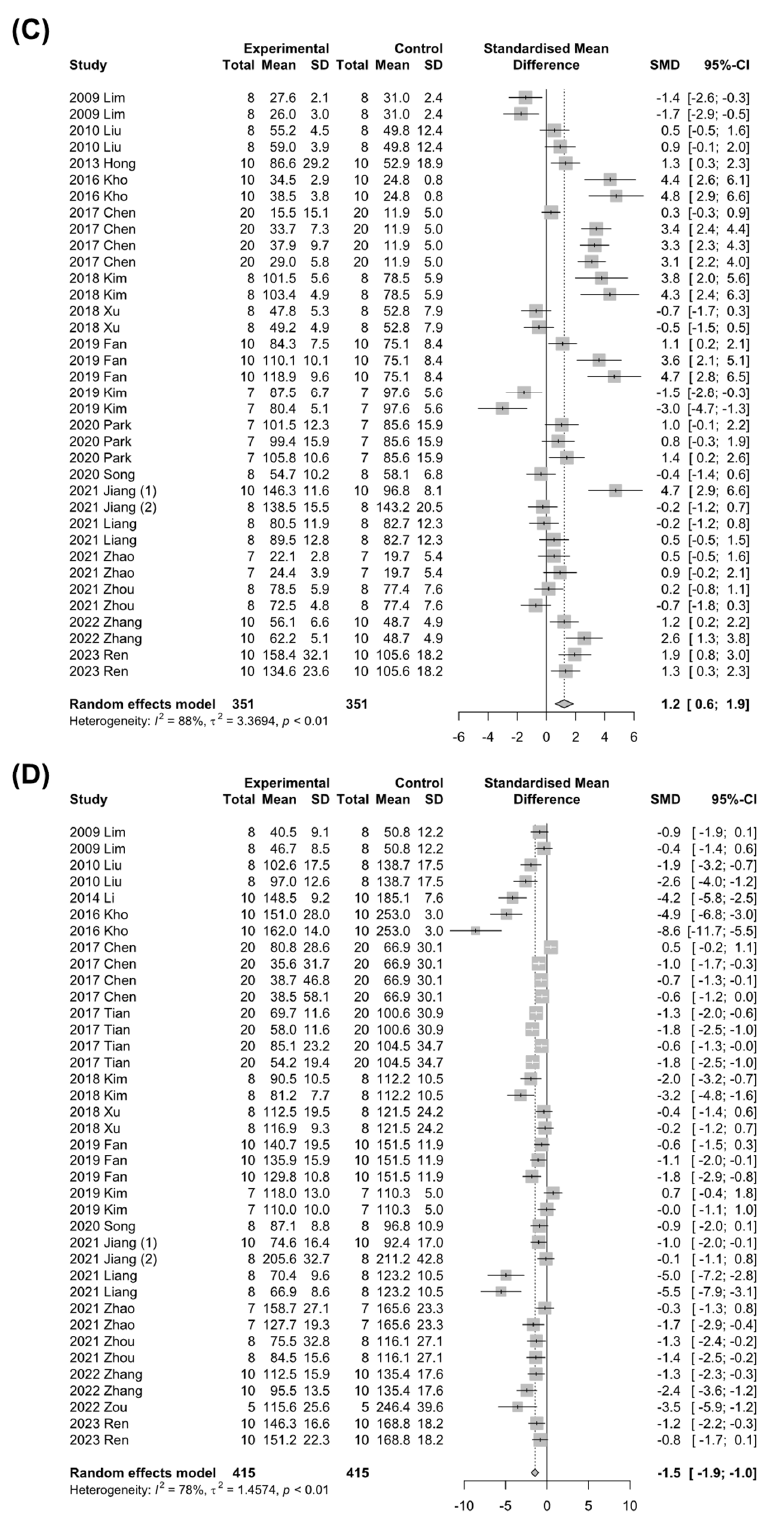
Figure 4. The effect of Panax ginseng on hepatic lipid metabolism in NAFLD-induced animals. Forest plots for comparison: ( A ) Triglyceride (TG) levels [7,19–30,32–35,38–41,44,46–52,56,58]. ( B ) Total cholesterol (TC) levels [7,19–21,23,25–30,32–35,38–41,44,46,47,49–52,56–58]. ( C ) High-density lipopro- tein (HDL) levels [7,19,21,23,27,28,32,35,38,39,44,46,49–52,56,58]. ( D ) Low-density lipoprotein (LDL) levels [7,19,21,25,27,28,30,32,35,38,39,46,49–52,56–58]. SD, standard